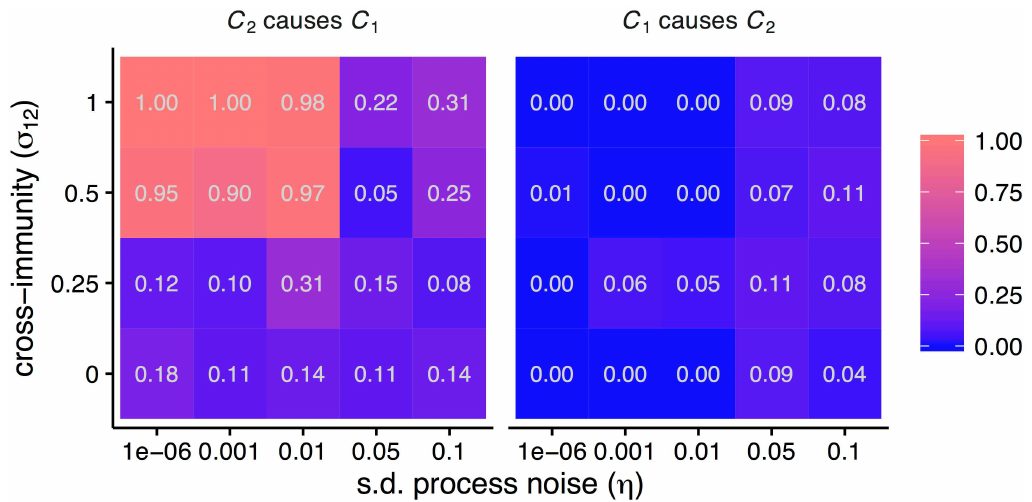
Fig 4. Interactions detected as a function of process noise and the strength of interaction ( C 2 ! C 1 ) and representative time series. Heat maps show the fraction of 100 replicatessignificantfor each inferred interactionfor different parameter combinations. A maximum, positive cross-map correlation ρ at a negativelag indicateda causal interaction. Each replicateused 100 years of monthly incidence.